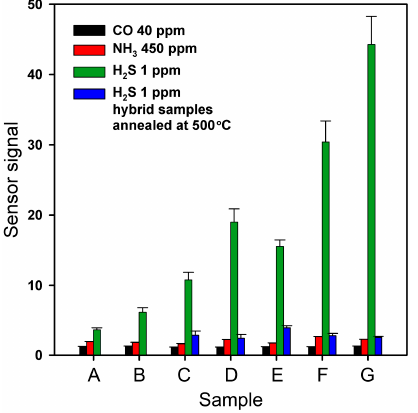
Figure 9. Sensor signal to CO (40 ppm), NH 3 (450 ppm), and H 2 S (1 ppm) for different samples: (A) SnO 2 ; (B) CuO/SnO 2 ; (C) CuPc/SnO 2 ; (D) CuBzPh/SnO 2 ; (E) CuChPh/SnO 2 ; (F) CuBiPy/SnO 2 ; (G) CuAzaCr/SnO 2 .